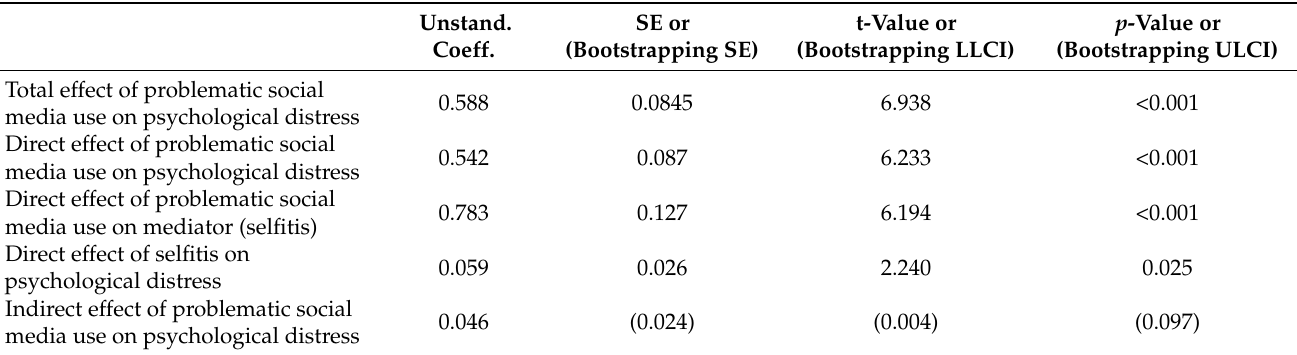
Table 3. Models of the effect of problematic social media use on psychological distress with selfitis as the mediator. Unstand.